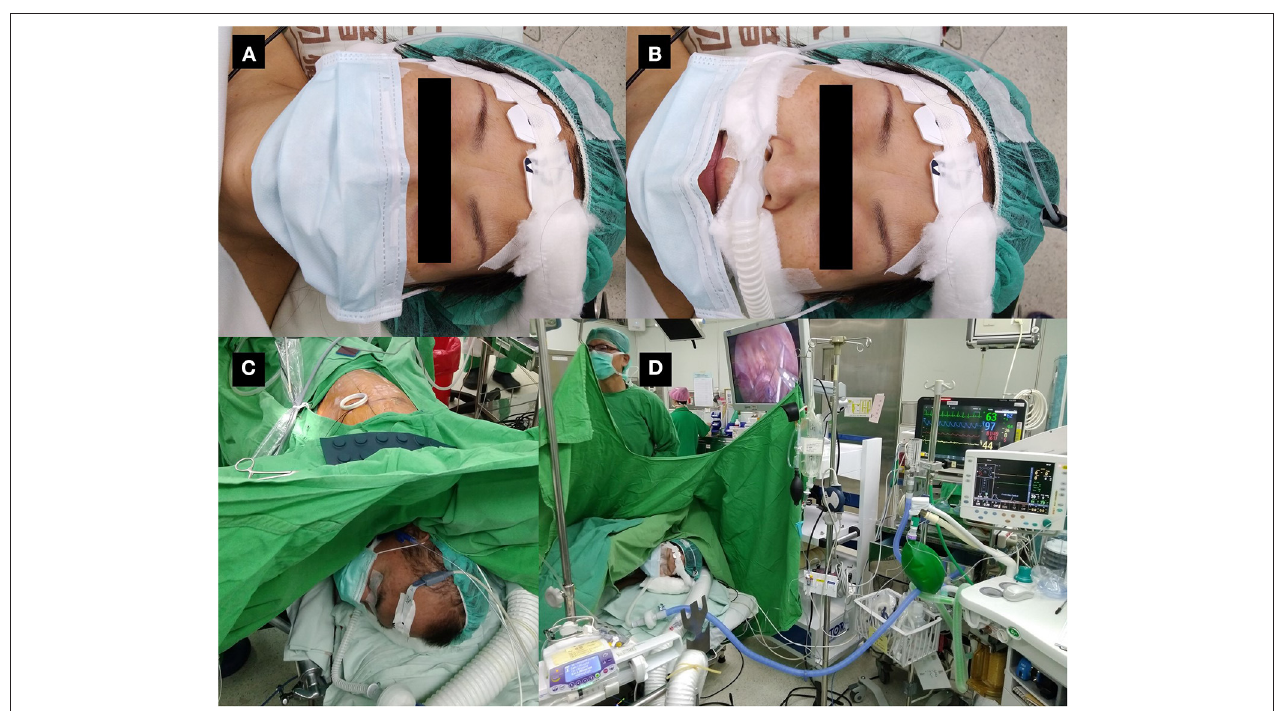
FIGURE 1 | Patient wearing a surgical mask during non-intubated thoracoscopic surgery. (A) Non-intubated patient wearing a surgical mask at the time of induction of anesthesia. (B) The same patient with the mask pulled down to demonstrate monitoring of exhaled carbon dioxide and high-flow nasal cannula under the mask. The mask will be re-covered before induction of anesthesia. (C) Patient undergoing non-intubated thoracoscopic surgery with a surgical mask. (D) Operation settings during non-intubated thoracoscopic